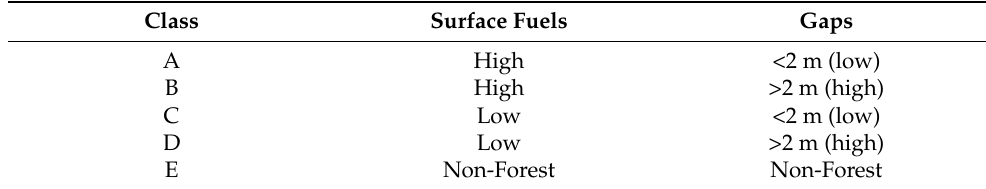
Table 1. Ladder fuel hazard assessment classifications, based on combination of surface fuel height and distance between surface fuels and canopy base. Adapted from Menning and Stephens [43]. High surface fuels refer to clumps of shrubs or small trees. Low surface fuels refer to a lack of clumped shrubs or small trees. Class Surface Fuels Gaps A High <2 m (low) B High >2 m (high) C Low <2 m (low) D Low >2 m (high) E Non-Forest